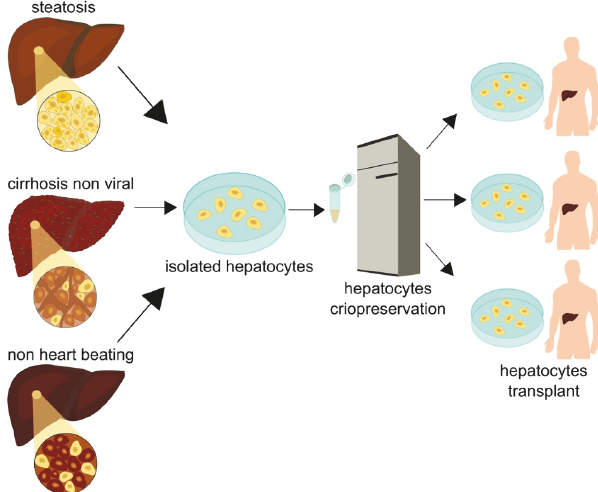
Figure 1: Each year a large number of livers from cadaverous donors are rejected for transplantation. The causes include a high degree of steatosis, no heart beating, and nonviral cirrhosis. These organs rejected for orthotopic transplantation have been object of studies and sources of great importance for obtaining liver cells for cell transplantation. The hepatocyte isolation with quality from these organs associated with cryopreservation technique will allow the development of a bank of liver cells that are available for the treatment of a large number of patients with